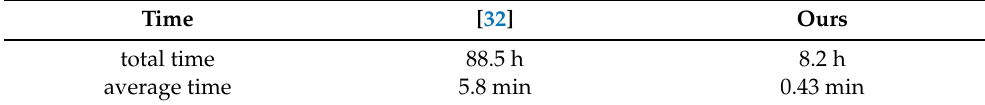
Table 3. Calculation time.